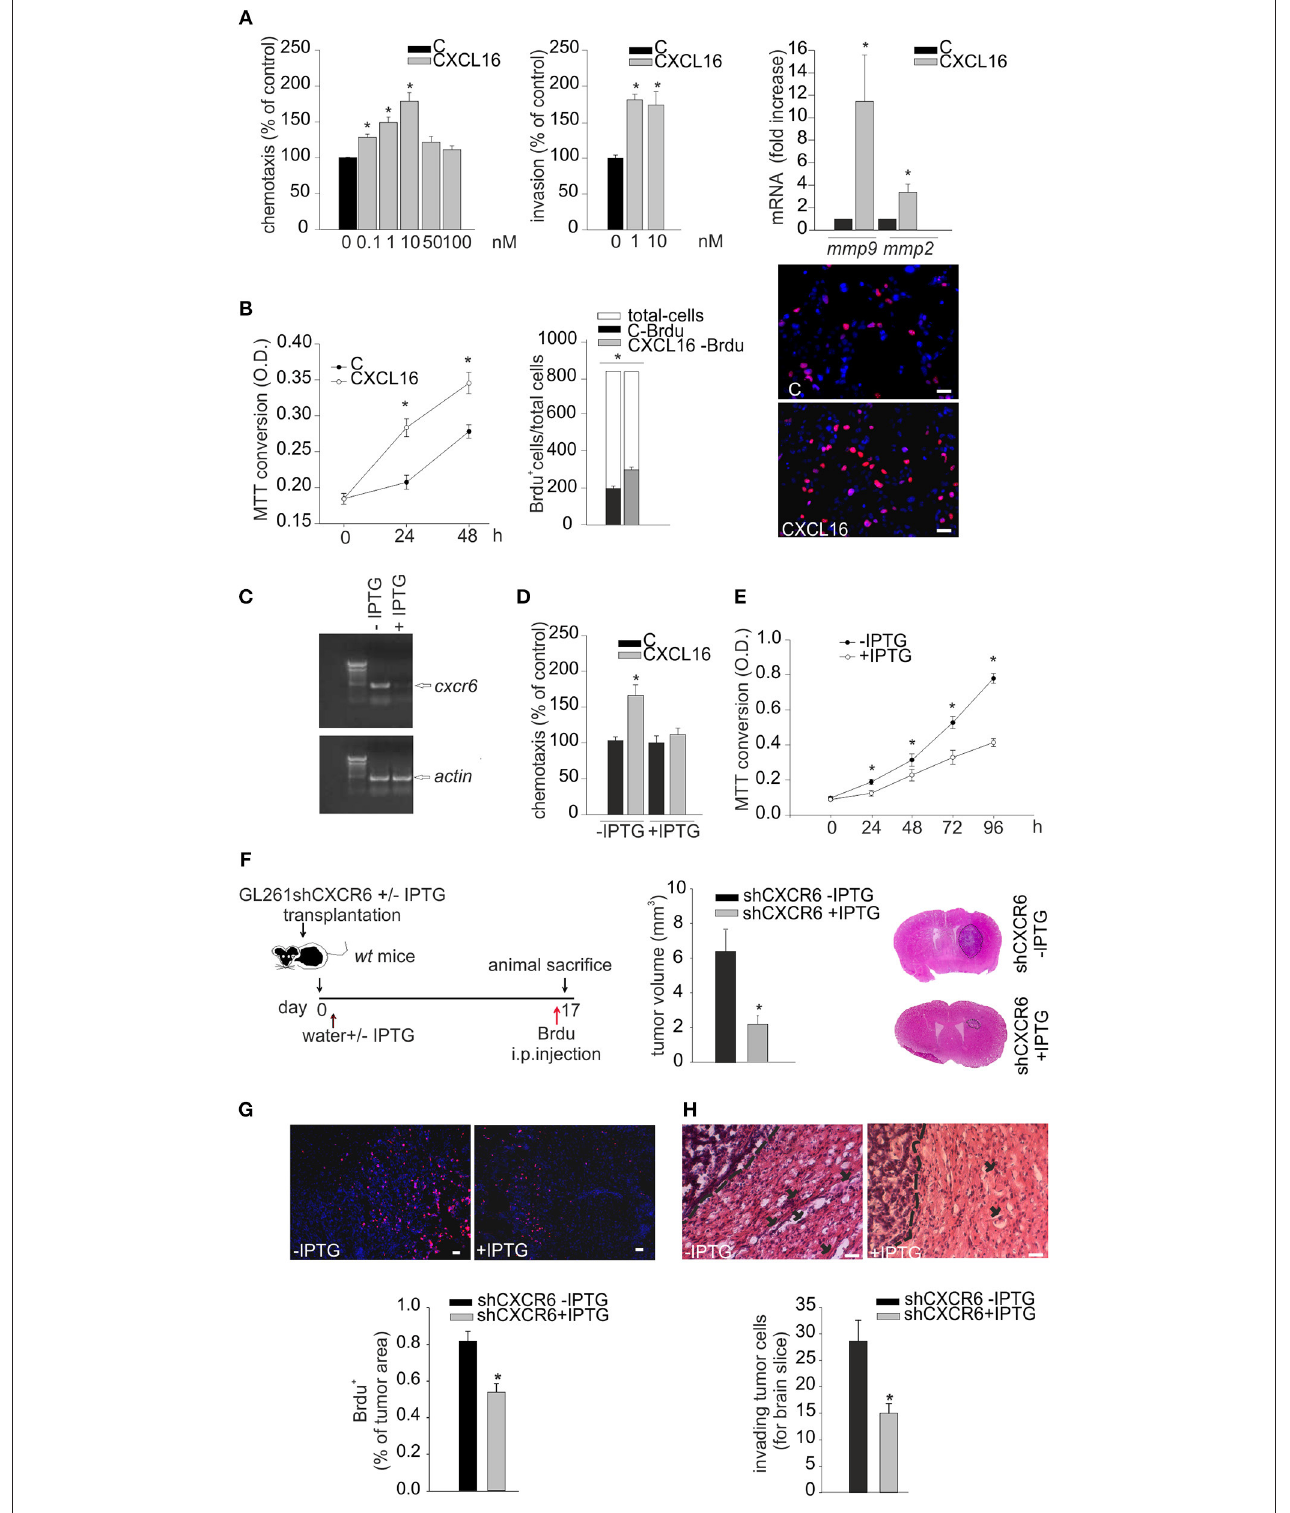
FIGURE 4 | Biological effects of CXCL16/CXCR6 axis on mouse glioma cells. (A) Left panel, chemotactic assay (24h) of GL261 cells in the absence (C) or presence of different doses of CXCL16. Data are expressed as percentage of cell migration toward CXCL16 vs. control. Central panel, invasion assay of GL261 cells